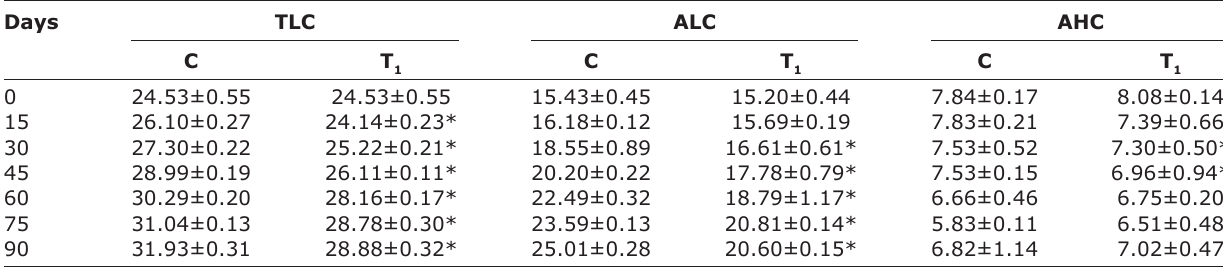
Table-1: Effect of CPF (mean±SE) on various leukocytic counts (10 3 /µl) in layers. Days